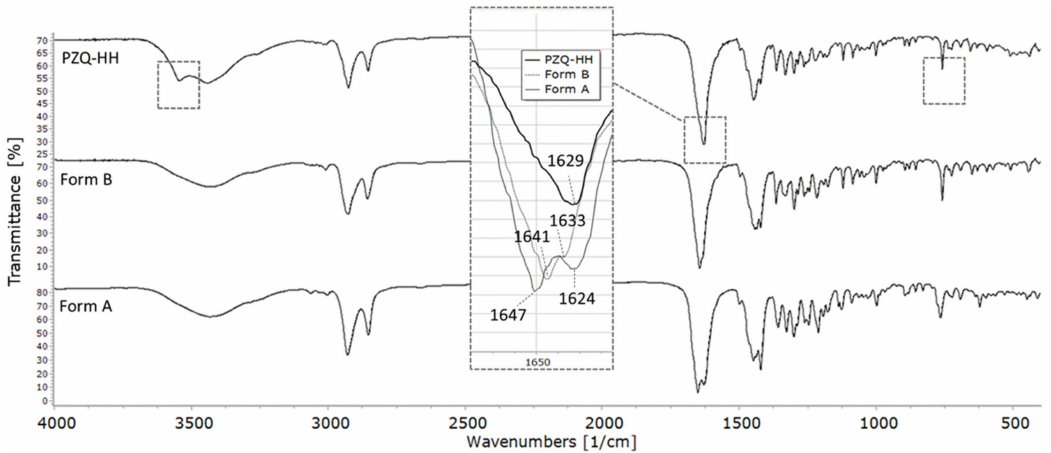
Figure 8. FT–IR spectra of ( top ) PZQ-HH, ( middle ) Form B and ( bottom ) Form A. Main di ff erences in comparison to the anhydrous forms are indicated in the frames.